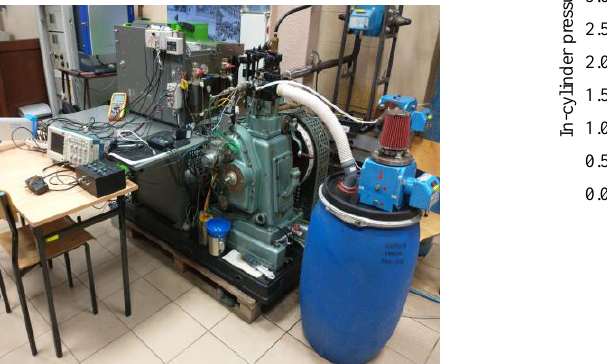
Fig. 5. In-cylinder pressure vs. crank